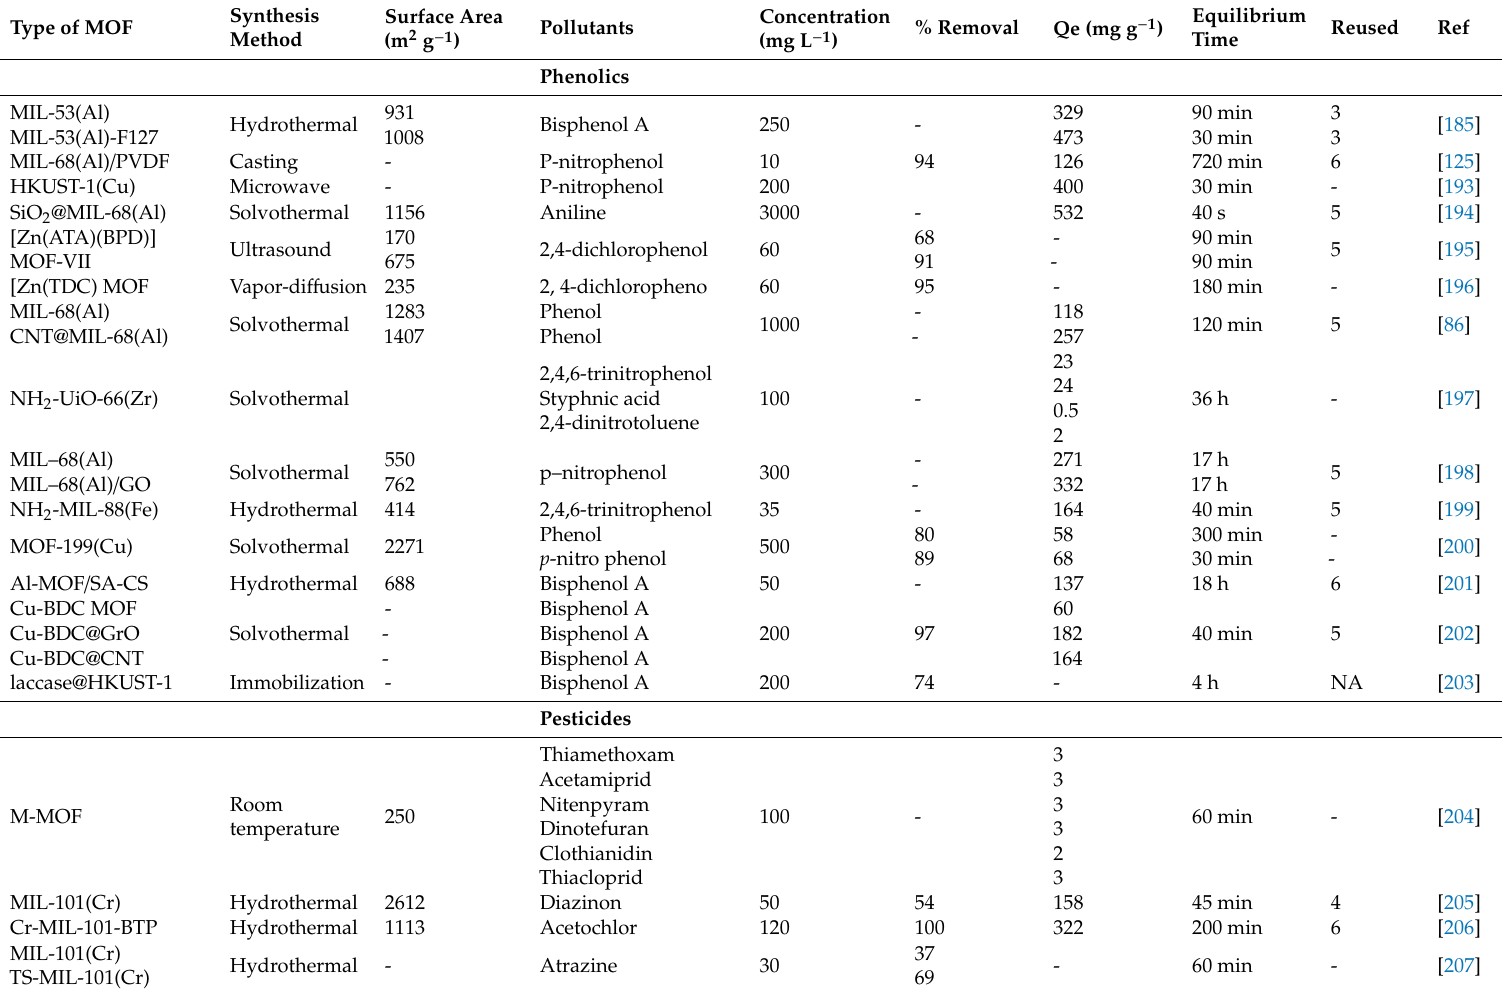
Table 3. MOFs and composites used for the adsorptions of phenols, herbicides, pesticides, and other miscellaneous organic